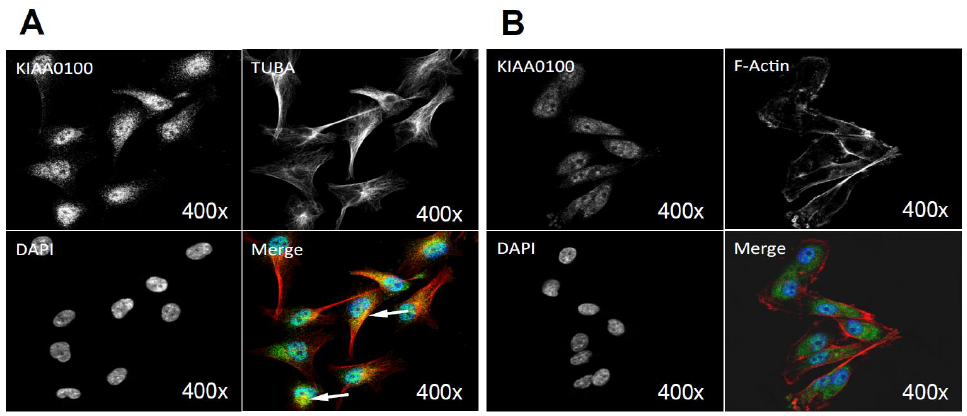
Figure 8 . Cont. Figure 8.